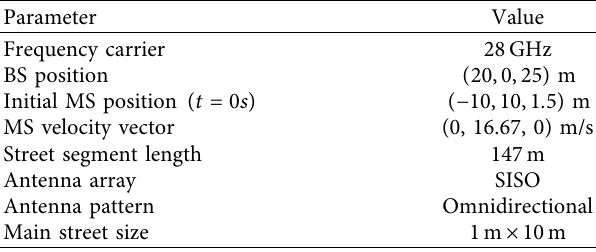
Figure 3: A diagram of the proposed quasiangles. Table 3: Parameter